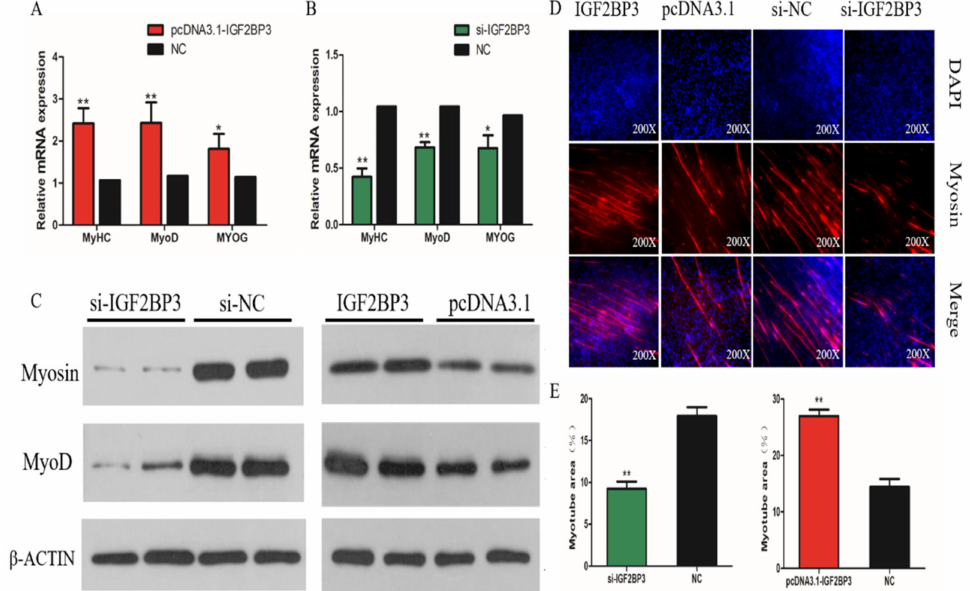
Figure 6. E ff ect of IGF2BP3 on di ff erentiation of SMSCs. ( A , B ) The relative expressions of MyoD, MyHC, and MyoG mRNA in SMSCs allowed to di ff erentiate for 48h. ( C ) The Western Blot results for protein levels of myogenic marker genes after inhibition and overexpression of IGF2BP3. ( D ) The Representative images of immunofluorescent staining of di ff erentiated SMSCs (200x). Myosin: red, a molecular marker of myogenesis; DAPI: blue, cell nuclei; Merge: the fusion of SMSCs into primary myotubes. ( E ) The Myotube area (%) after the transfection of si-IGF2BP3, pcDNA3.1-IGF2BP3 or negative control. The data are expressed as mean ± SEM ( n = 6). * p < 0.05; ** p < 0.01 vs.